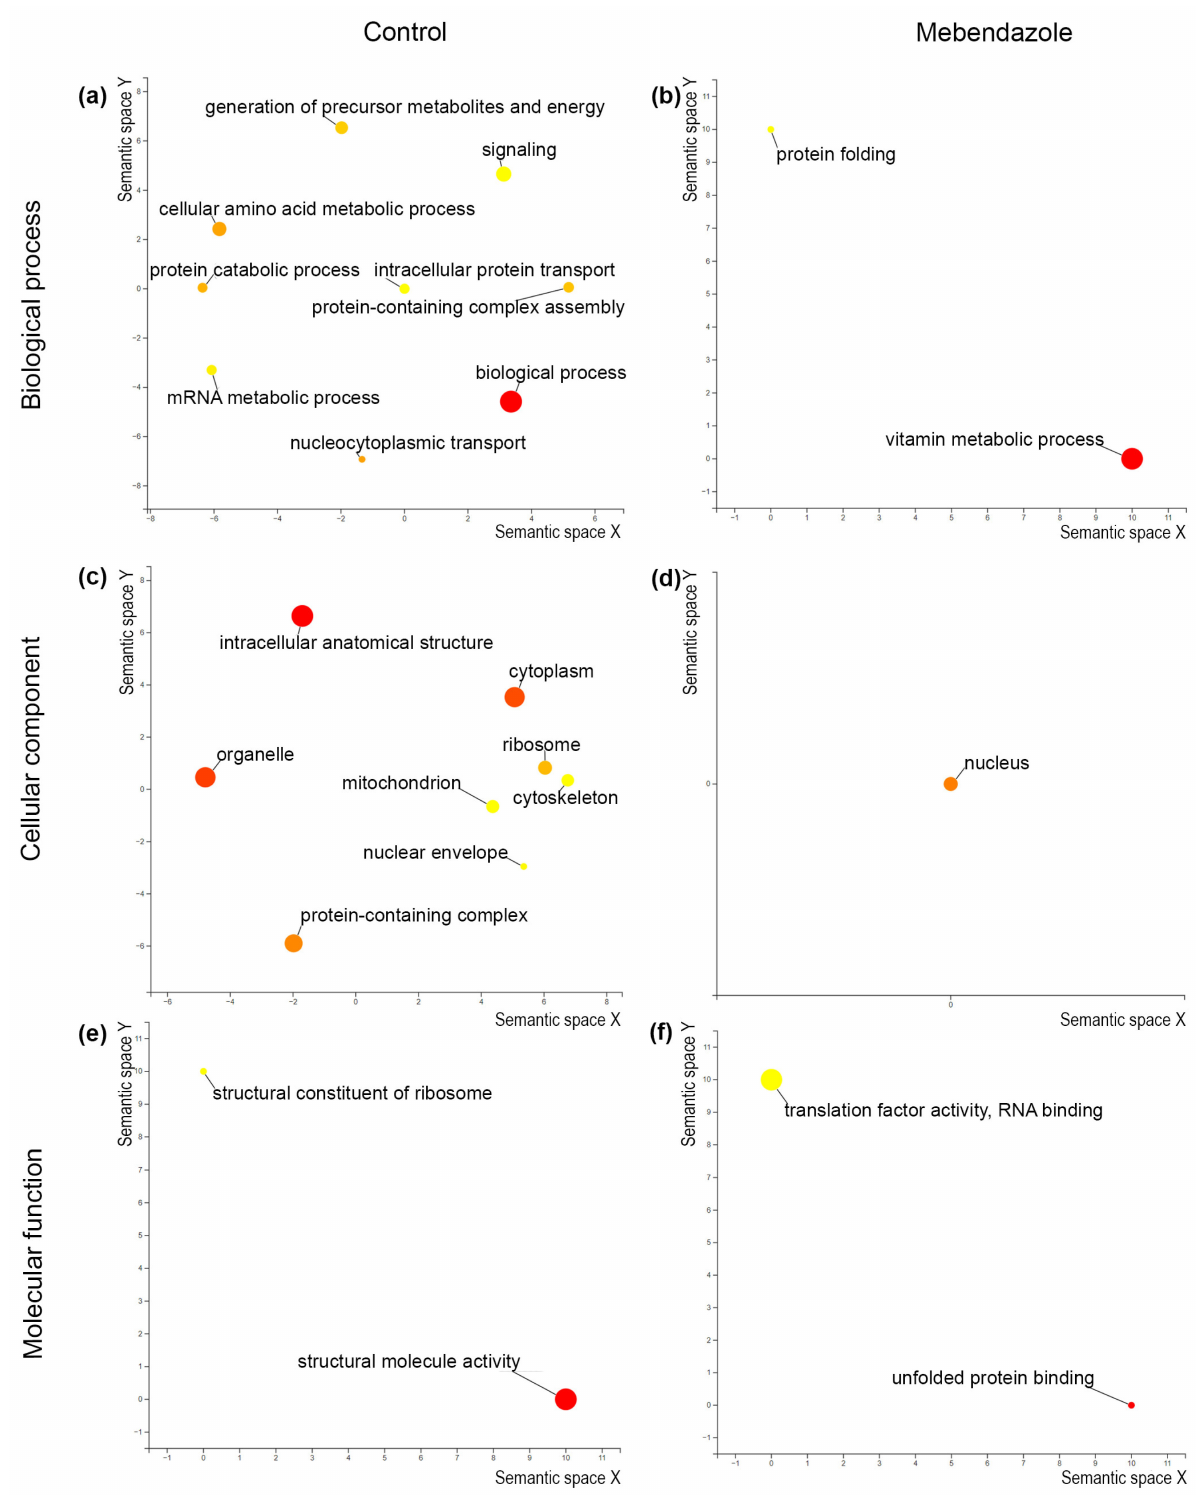
Figure 3. Enriched GO Slim terms in control and mebendazole-treated H. capsulatum : biological function ( a , b ); cellular component ( c , d ) and molecular function terms ( e , f ) are presented in control ( a , c , e ) and mebendazole-treated ( b , d , f ) proteomes. Revigo uses Multidimensional Scaling to reduce the dimensionality of a matrix of the GO terms’ pairwise semantic similarities. The resulting projection may be highly non-linear and the axes have no intrinsic meaning. The guiding principle is that semantically similar GO terms should remain close together in the